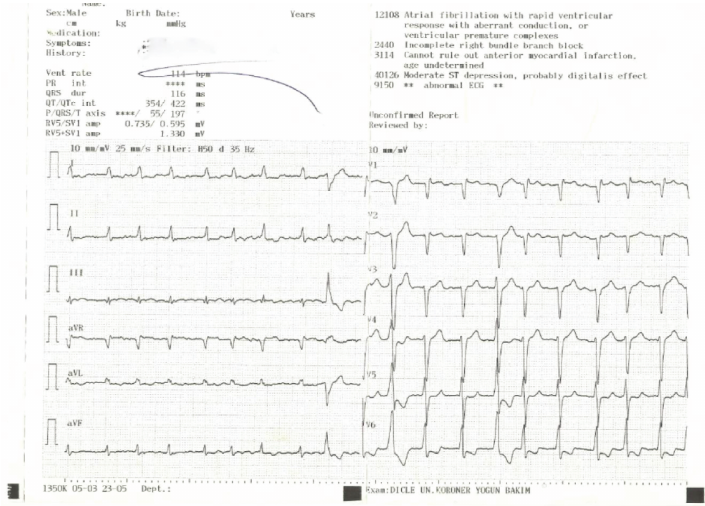
Figure 1: 12-lead electrocardiogram of the patient on admission.